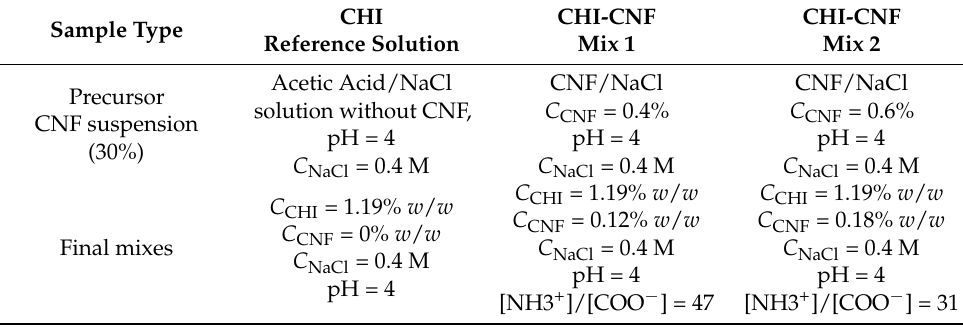
Table 1. Parameters of formulation used for the preparation of CHI/CNF mixtures from precursors CHI acetate solutions and CNF suspensions, and of the resulting formulations of two CHI/CNF mixtures, before dialysis and gelation. C CHI : mass concentration of chitosan (CHI); C CNF : mass concentration of nanofibrilated